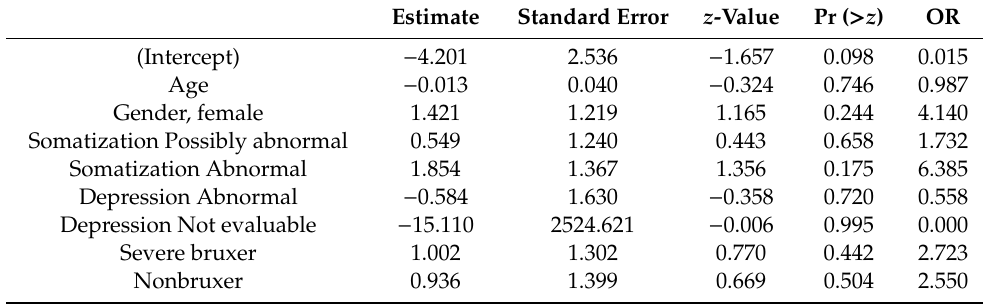
Table 6. Multivariate logistic regression model with RDC / TMD group III (arthralgia, osteoarthritis and osteoarthrosis as the dependent variable. Estimates of the model coe ffi cients.